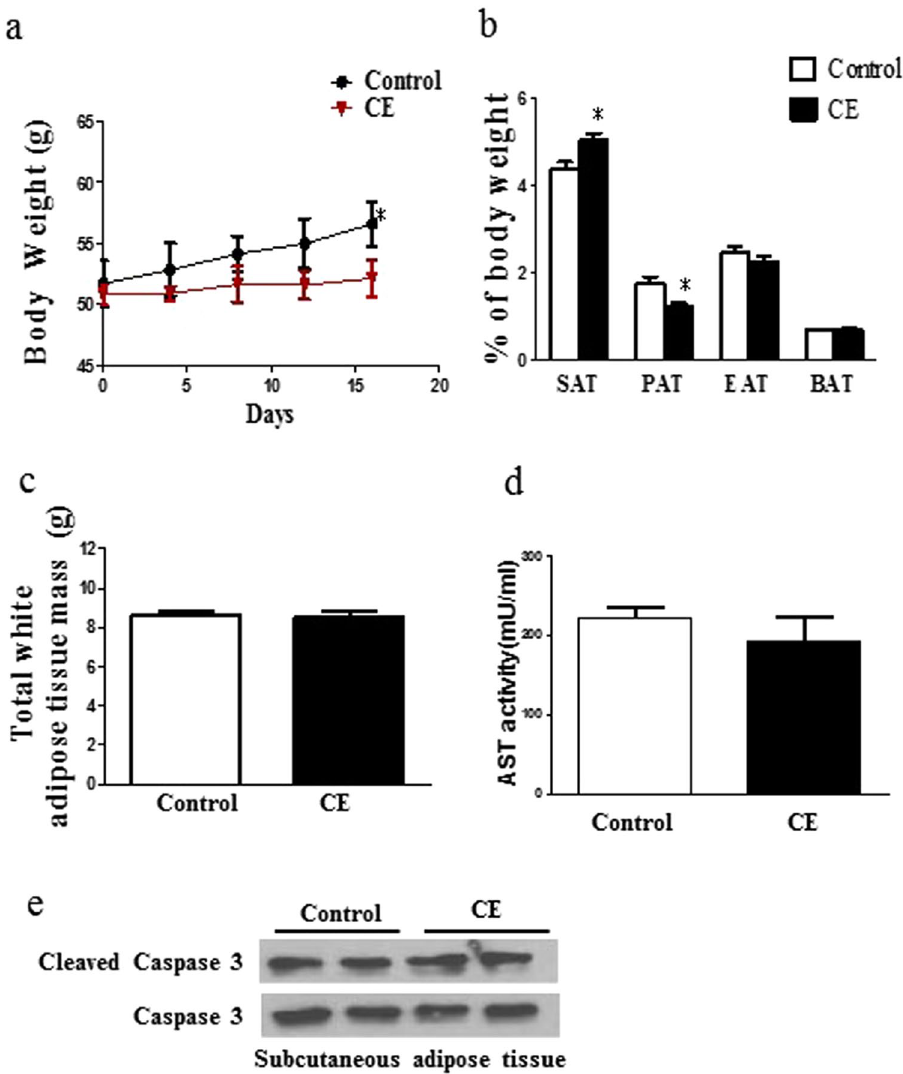
Figure 8. ( a ) Body weight of vehicle control and CE-treated mice. ( b ) Weights of different fat depots, presented in the percentage of body weights. ( c ) Total white adipose tissue mass of the mice. ( d ) Aspartate aminotransferase (AST) levels in the mice. ( e ) Expression of caspase 3 and cleaved caspase 3 in the subcutaneous adipose of the vehicle control and CE-treated mice. CE, cinnamon extract (500 mg/kg body weight). SAT, subcutaneous adipose tissue; PAT, perinephric adipose tissue; EAT, epididymal adipose tissue; BAT, brown adipose tissue. * p < 0.05, n = 3 individual